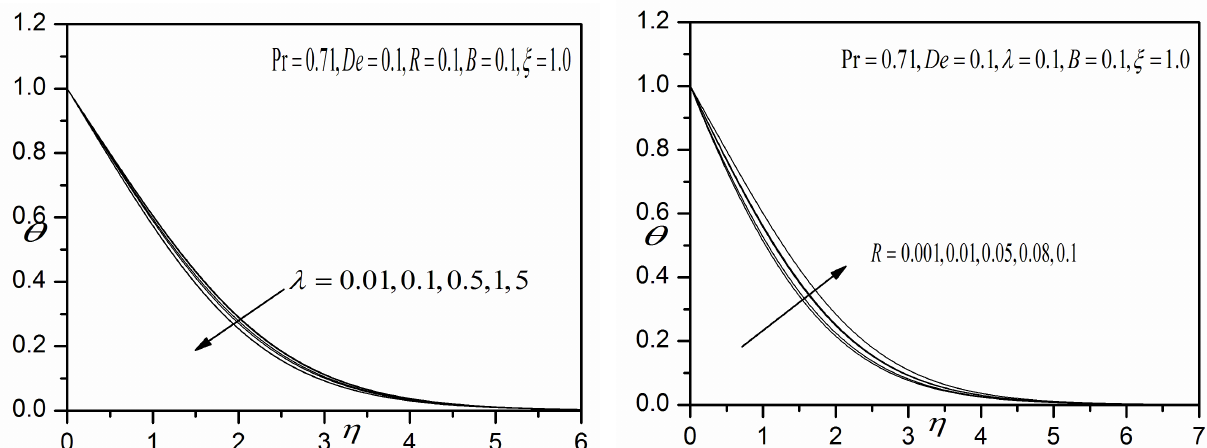
Fig. 9: Influence of R on the temperature.